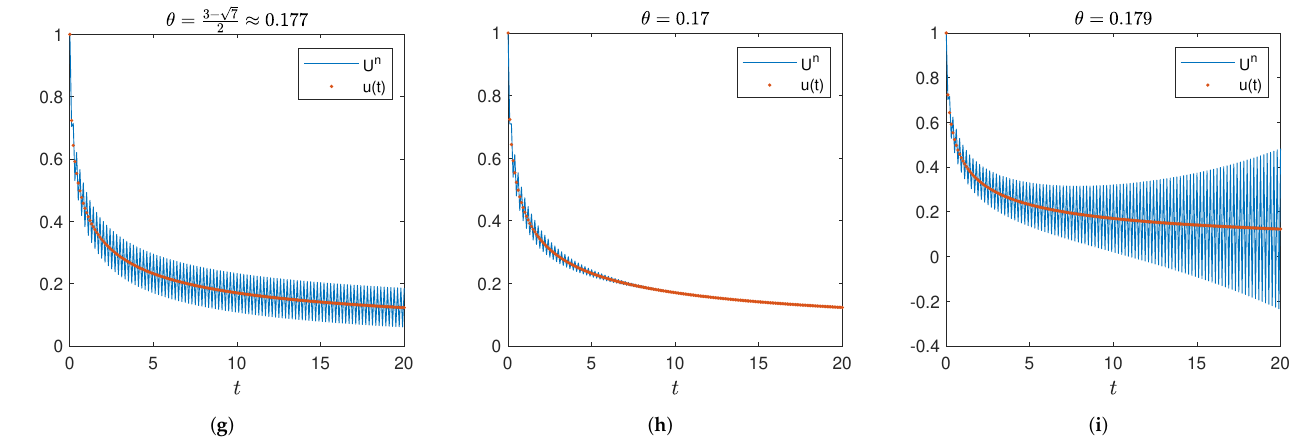
Figure 1. Justification of the sharpness of Theorem 2 when using the polynomial-type transform function Θ ( ζ ; θ ) for Example 1. ( a – c ): exact solution u ( t ) vs. numerical solution U n obtained by the transformed 2nd-order Newton–Gregory formula. ( d – f ): exact solution u ( t ) vs. numerical solution U n obtained by the transformed 3rd-order Newton–Gregory formula. ( g – i ): exact solution u ( t ) vs. numerical solution U n obtained by the transformed fractional BDF-4.